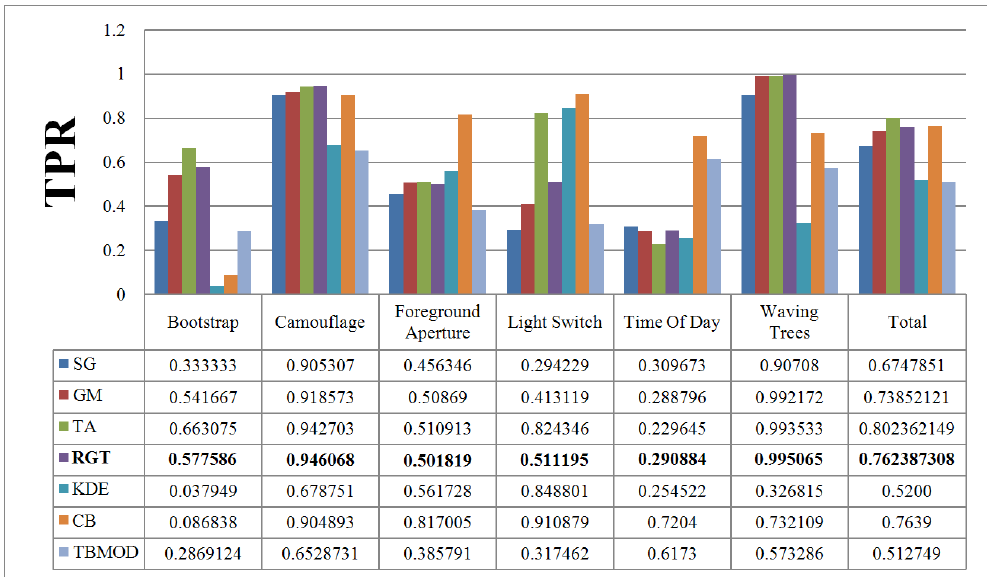
Figure 8. False Positive Rate of various background subtraction methods for the Wallflower